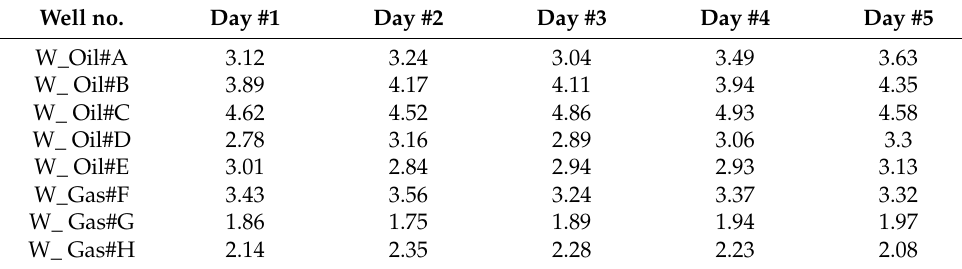
Table A1. Daily measurement of produced water in PFF system in HF process in MM m 3